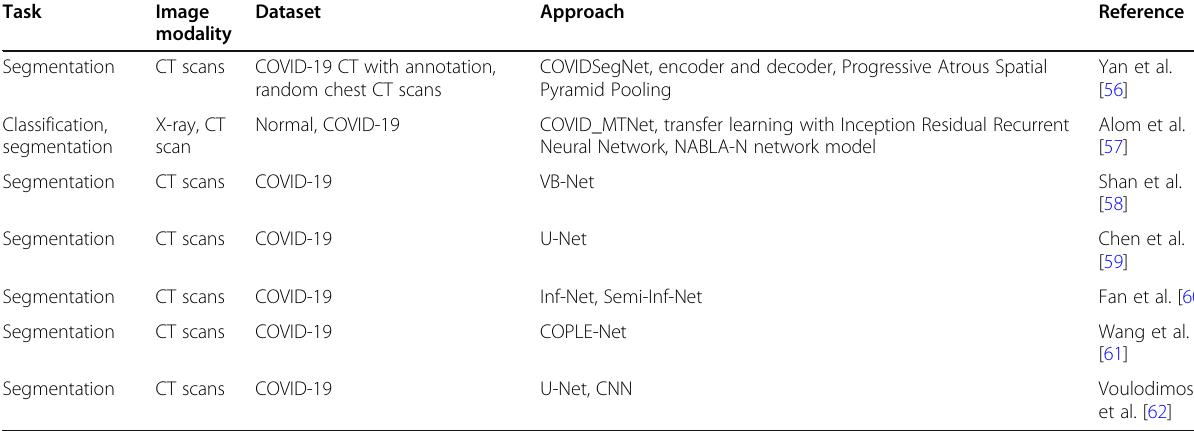
Table 3 List of CNNs used for COVID-19 image